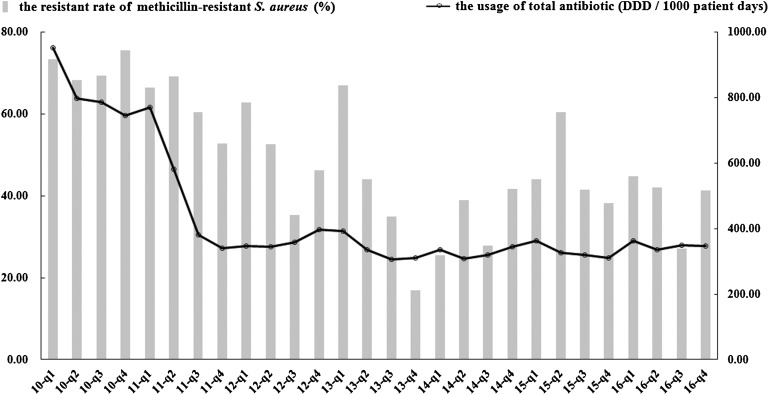
Trends in the rate of resistance to methicillin-resistant S. aureus (MRSA) and the quarterly usage of total antibiotics during 2010–2016. The usage of total antibiotics is represented as DDD per 1000 patient days on the right y-axis. Resistance rates are shown on the left y-axis. DDD, defined daily dose.